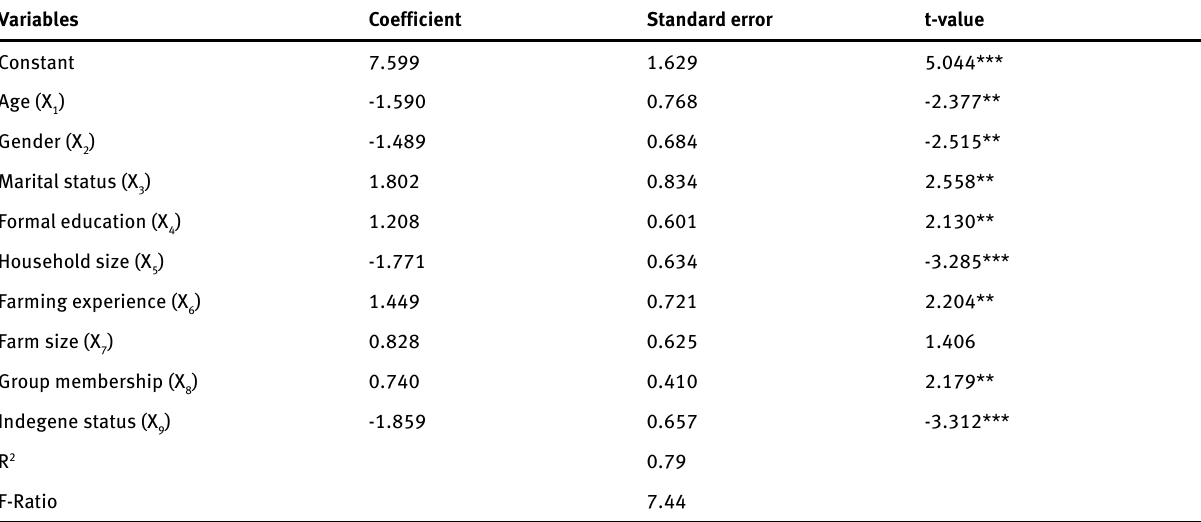
Table 5: Estimation of the influence of socio-economic characteristics on social inclusion